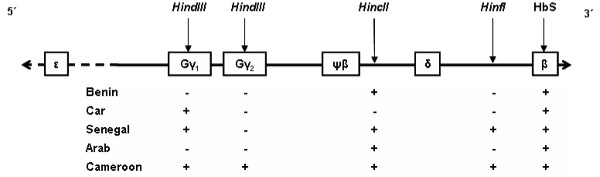
Classical βS haplotypes. The figure illustrates restriction fragment length polymorphisms in a 70 kb region around HBB. Five other globin synthesis genes are shown along with the approximate positions of four RFLP sites used to designate the five classical βS haplotypes.